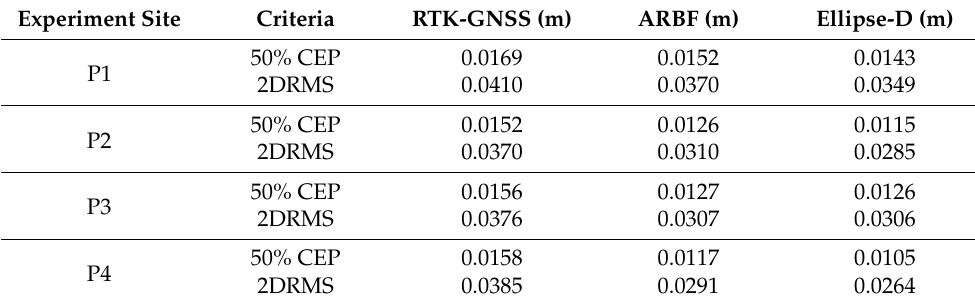
Figure 7. Results of static experiments: ( P1 ) data points distribution for P1; ( P2 ) data points distribu- tion for P2; ( P3 ) data points distribution for P3; ( P4 ) data points distribution for P4. Table 2. Results of 50% CEP and